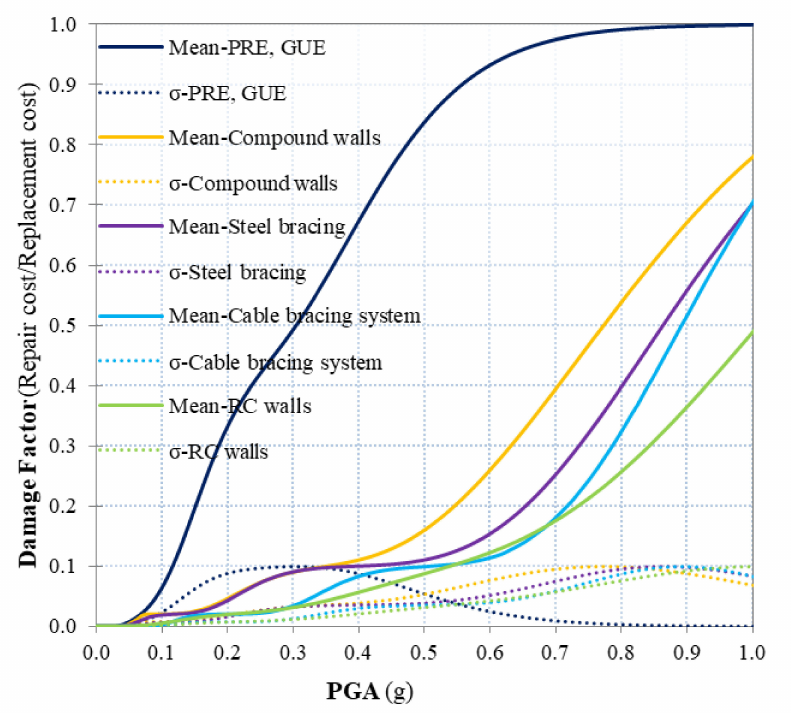
Figure 11. Vulnerability functions of the retrofitted and un-retrofitted school buildings.